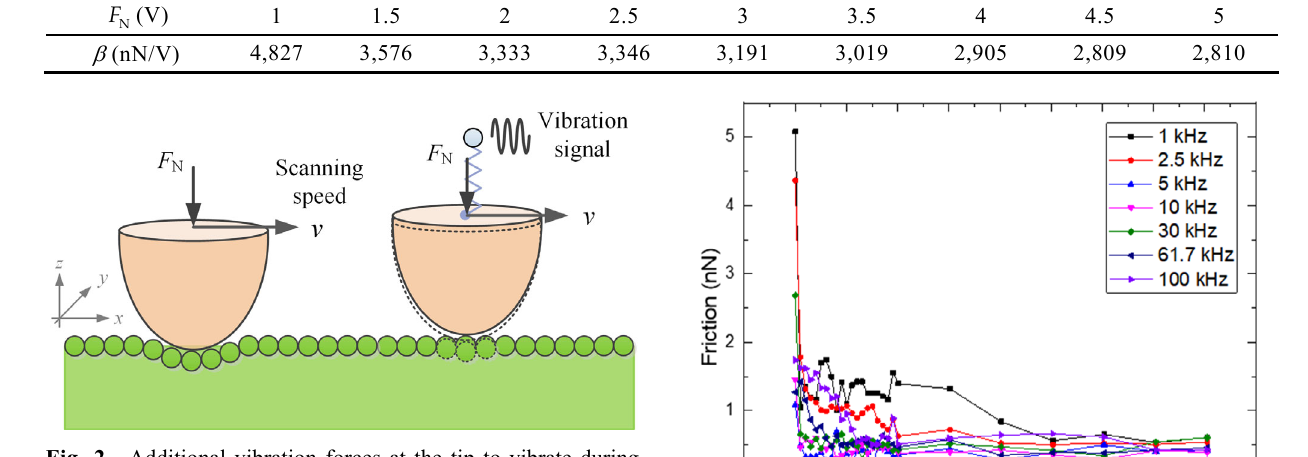
Fig. 2 Additional vibration forces at the tip to vibrate during normal friction movement. The F was monitored using a N four-quadrant photodetector and controlled by a real-time feedback circuit. v is the scanning speed. Fig. 3 Friction (average frictional force) detected through scanning and z -directional excitation on the HOPG surface as a function of the vibration amplitude (0–16 nm) for different vibration frequencies (1, 2.5, 5, 10, 30, 61.7, and 100